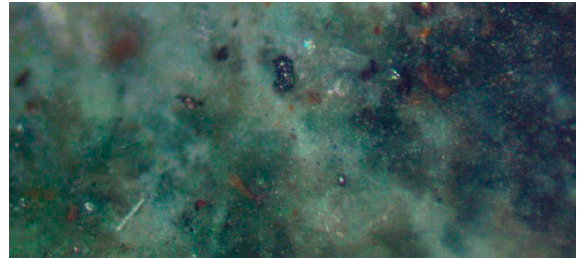
Figure 3. ST Trial Pellet (ST1b [16]) Following Desalination: Reflected Light; Halite infilling porosity on polished cut surface. Field of view = 0.49 mm; ZVI:water ratio = 23.10 g/L; Feed water salinity = 8.21 g/L; Product water salinity after 230 days = 1.99 g/L. NaCl removed = 6.22 g/L (0.27 g/g ZVI). Feed water pH = 6.25; Product water pH = 8.15. Hydrology 2016 , 3 , 45